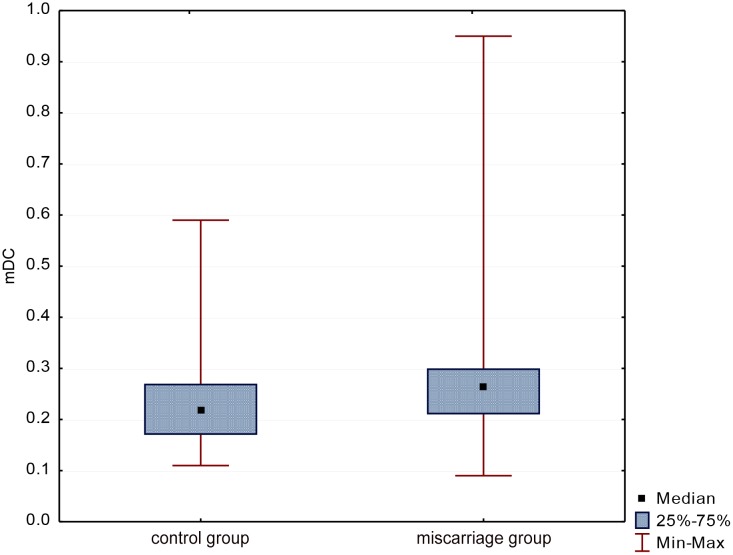
Evaluation of mDCs percentage in groups.